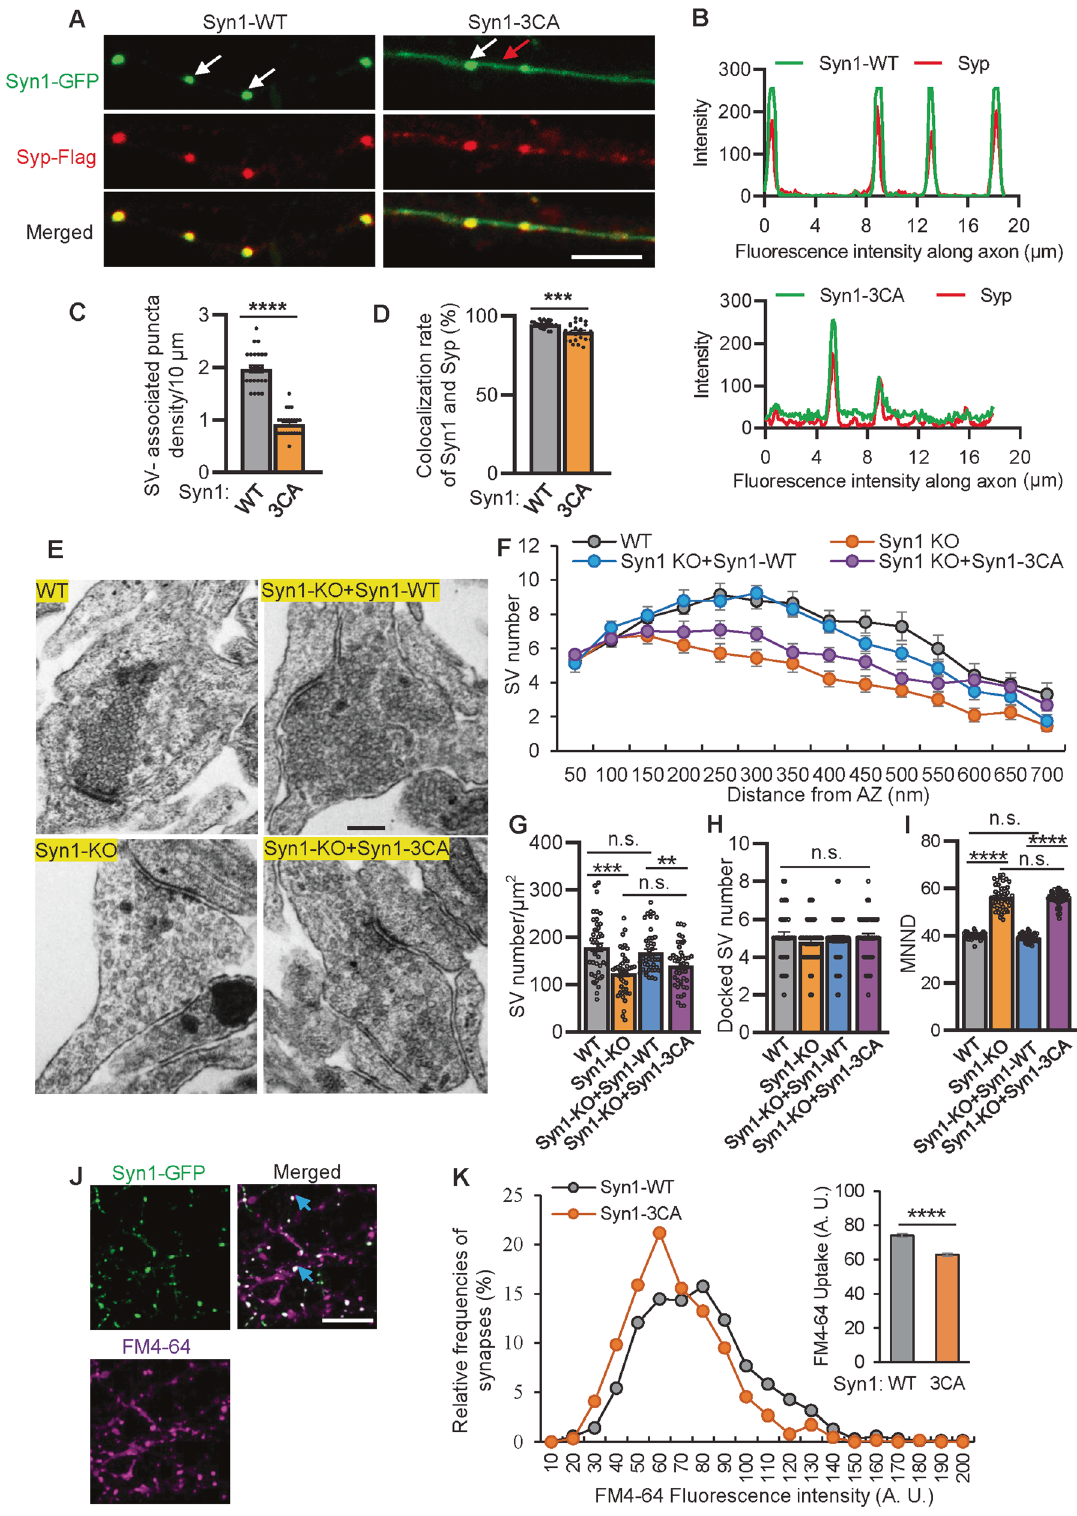
YFP n -Syn1 (1) + YFP c - β -actin (3) for BiFC, Fig. S5B, C) was carried out to visualize the binding of Syn1 with F-actin ex vivo. The fl uorescence images demonstrated that while Syn1-WT interacts with β -actin and illuminates YFP, decreasing the level of palm- Syn1 by either cysteine mutations (Syn1-3CA or other mutants) or